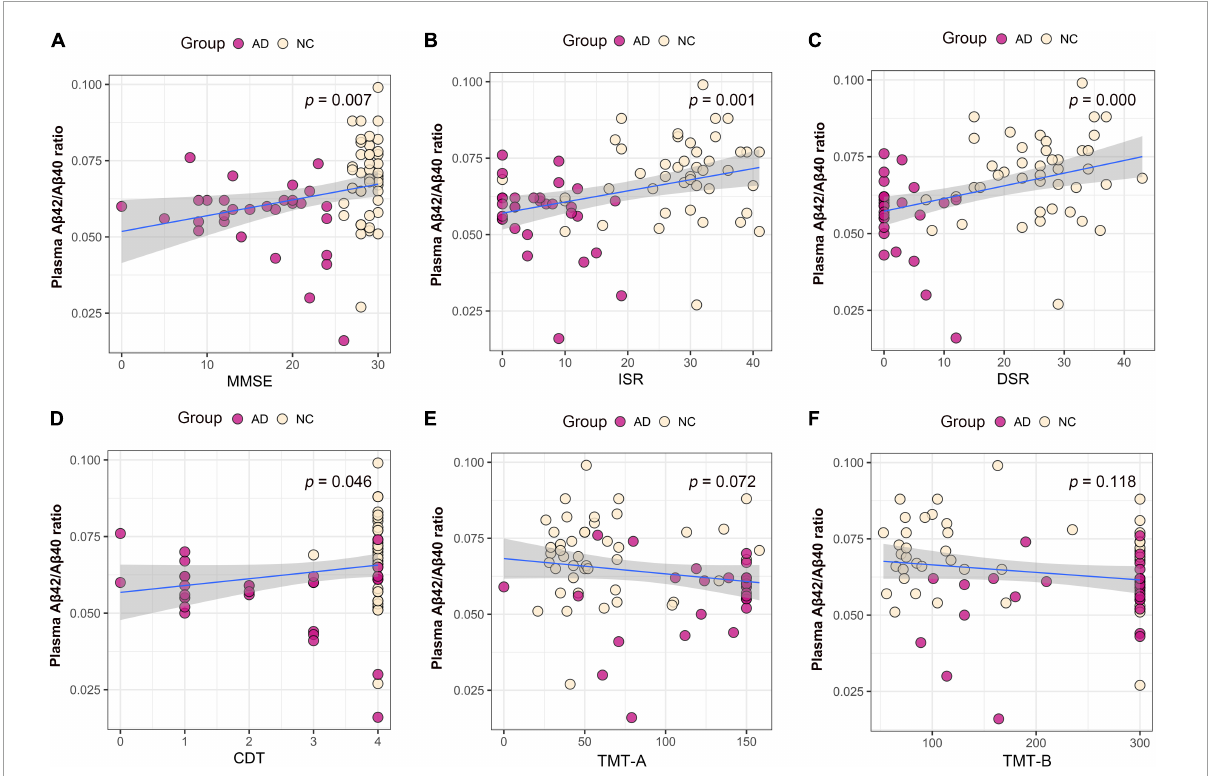
FIGURE2 Association between plasma A β 42/A β 40 ratio and cognitive domains. (A) Association between plasma A β 42/A β 40 ratio and MMSE. (B) Association between plasma A β 42/A β 40 ratio and ISR. (C) Association between plasma A β 42/A β 40 ratio and DSR. (D) Association between plasma A β 42/A β 40 ratio and CDT. (E) Association between plasma A β 42/A β 40 ratio and TMT-A. (F) Association between plasma p-tau181 and TMT-B. Multiple regression analysis was used and adjusted for years of education. AD, Alzheimer’s diseases; NC, normal control;